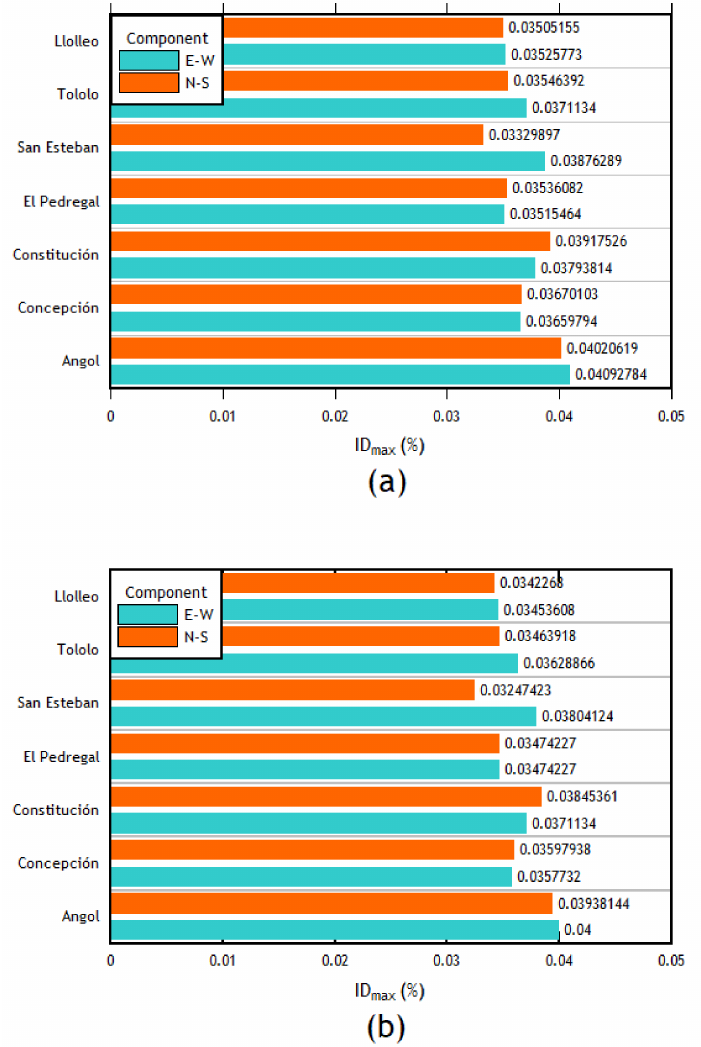
Figure 11. Interstory drifts of ( a ) the right column of frame 4 and ( b ) the right column of the frame 4 transverse